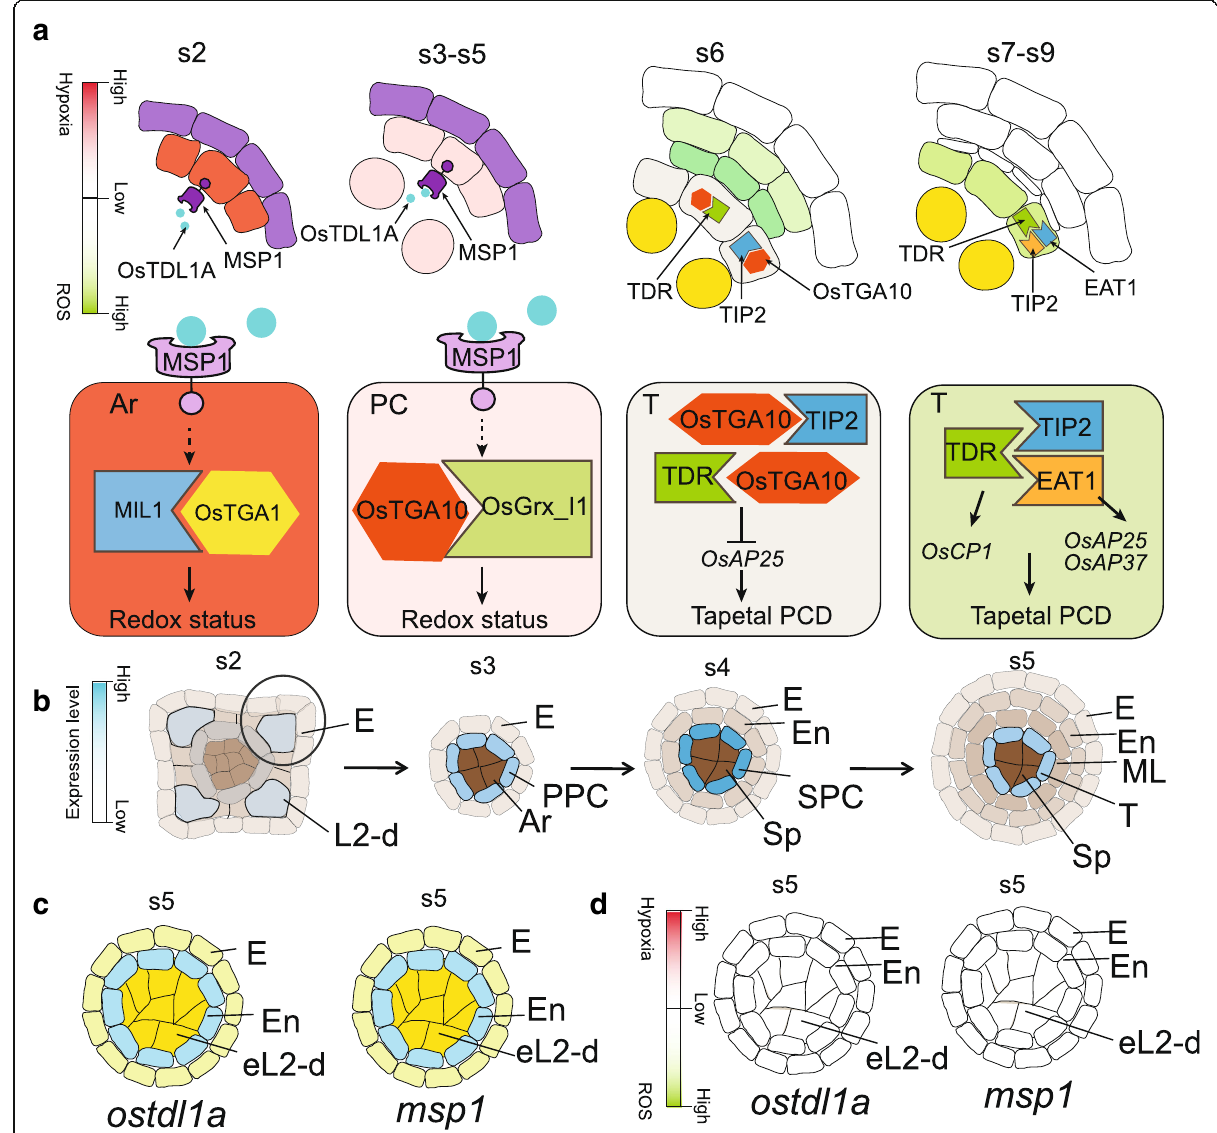
Fig. 3 OsTDL1A-MSP1 pathway regulates anther development. a Model for protein interaction on tapetum development. b Expression pattern of OsTDL1A or MSP1 in anther. c ostdl1a and msp1 anthers with excess L2-d cells at stage 5. d ostdl1a and msp1 anthers with undetectable ROS at stage 5. Red color in a shows the gradients of hypoxia status; green color in a shows the gradients of ROS level; purple color in a shows no discussion about the redox status; white color in a and d shows undetectable level of ROS by DAB staining; yellow color in a shows germ cells; blue color in b shows the gradients of gene expression; grey color in b shows different cell layers without the expression of OsTDL1A or